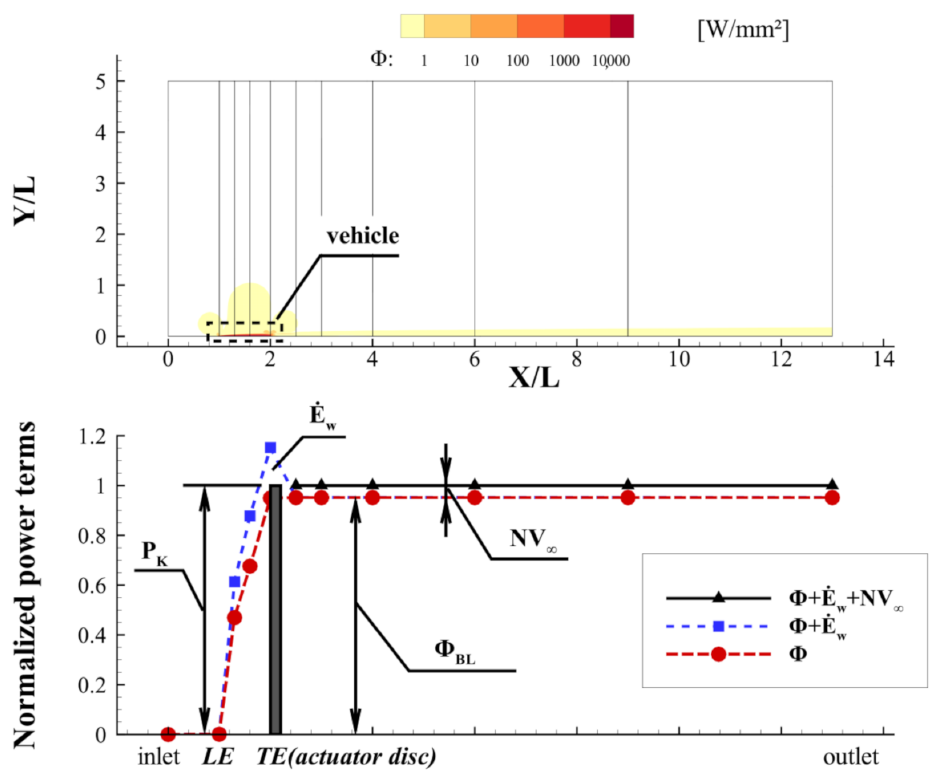
Figure 12. Contours of the integrand of viscous dissipation ( top ) and the power bookkeeping of the integrated vehicle ( bottom )